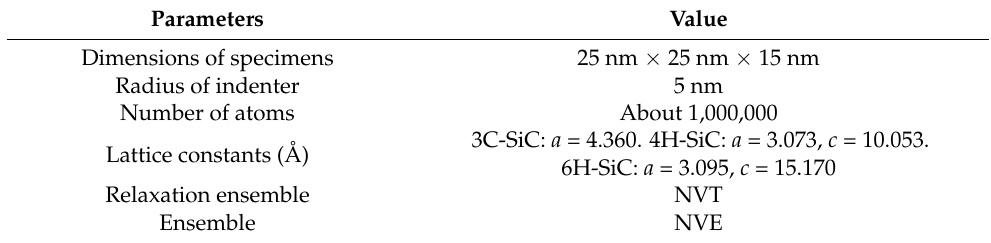
Table 1. Main parameters of the simulation